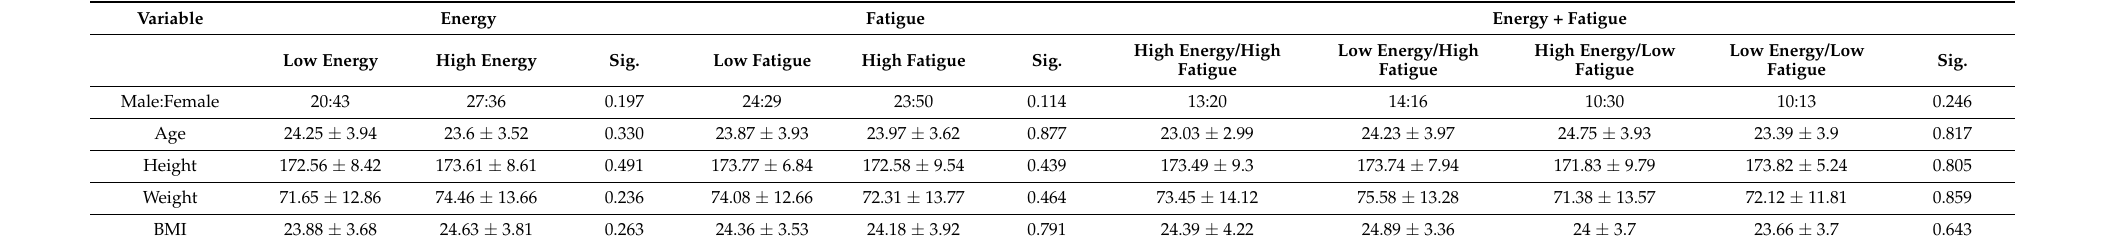
Table 1. Participant characteristics.